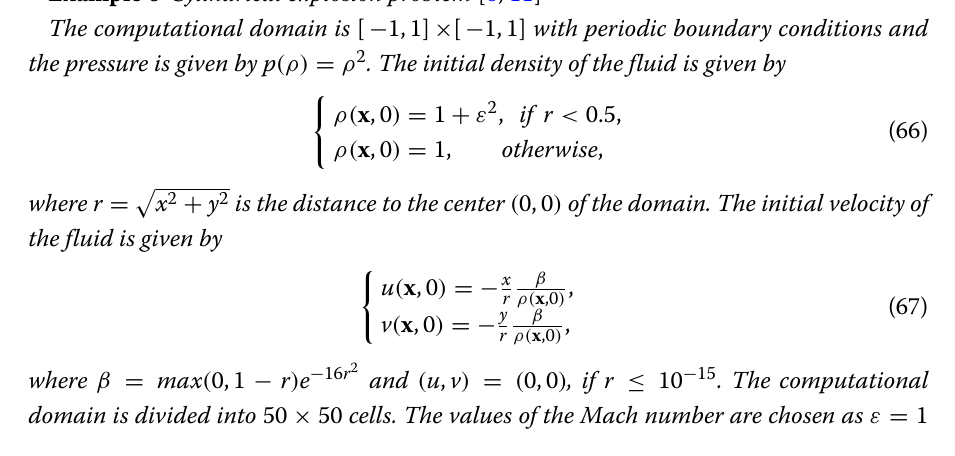
Table 8 Example 4. L 1 errors and numerical orders of temporal accuracy obtained with the GSA IMEX-ARS3 WCNS at t = 0.02 M ×